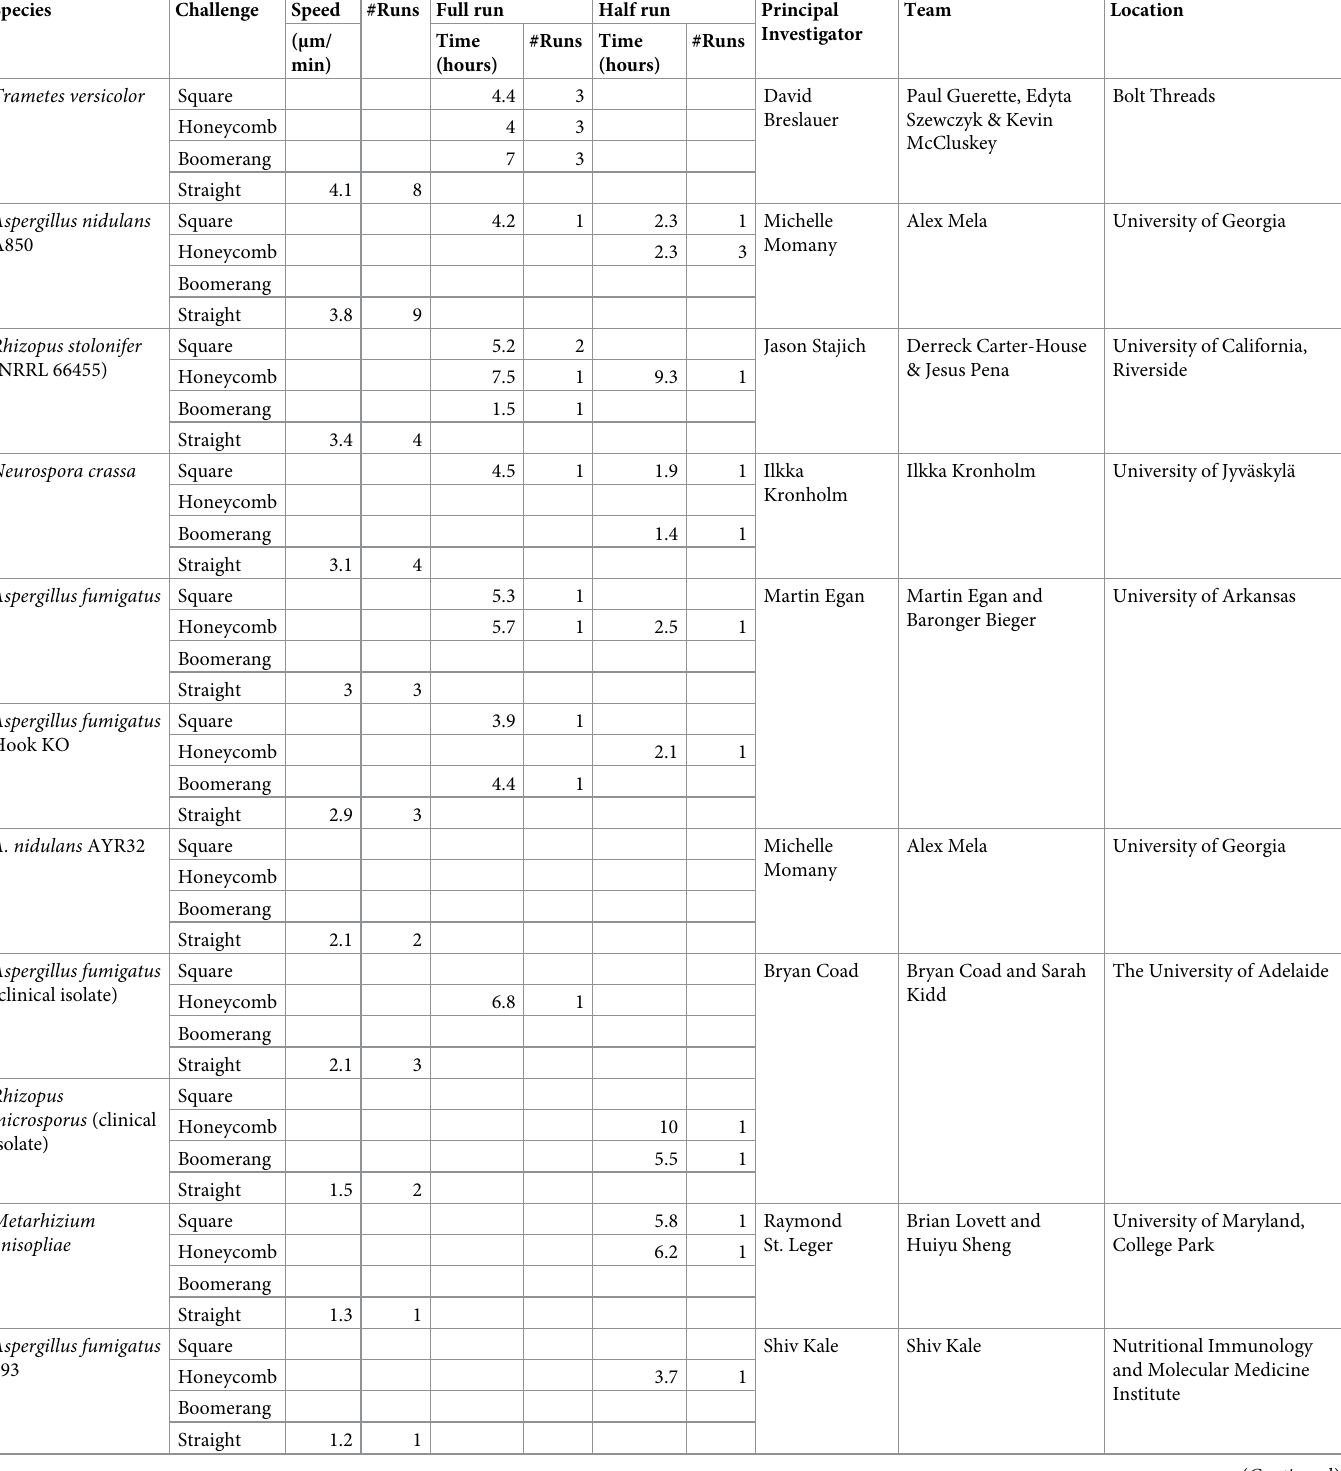
Table 1. Fungus Olympics challengers results and teams.